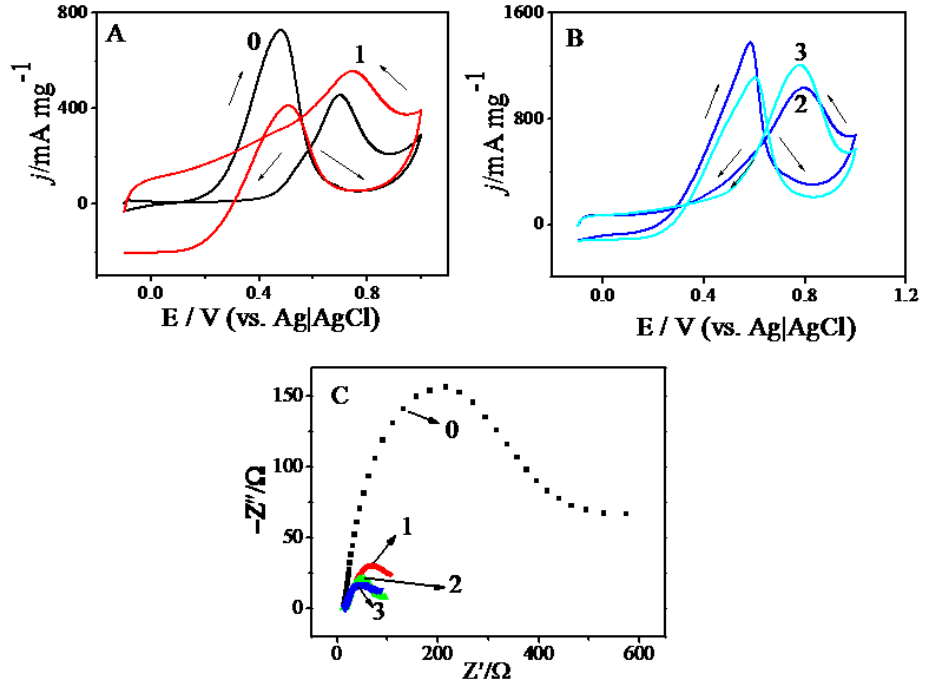
Figure 5. ( A ) CV curves in 1 M CH 3 OH + 0.5 M H 2 SO 4 at 100 mV ∙ s − 1 : Pt/C ( 0 ), Pt/GNs ( 1 ); ( B ) CV curves in 1 M CH 3 OH + 0.5 M H 2 SO 4 at 100 mV ∙ s − 1 : Pt/GNs (CS) ( 2 ), Pt/GNs (PAMAM) ( 3 ); ( C ) Nyquist plots of EIS for methanol electrooxidation in 1 M CH 3 OH + 0.5 M H 2 SO 4 solution: Pt/C ( 0 ), Pt/GNs ( 1 ), Pt/GNs (CS) ( 2 ), Pt/GNs (PAMAM) ( 3 ).